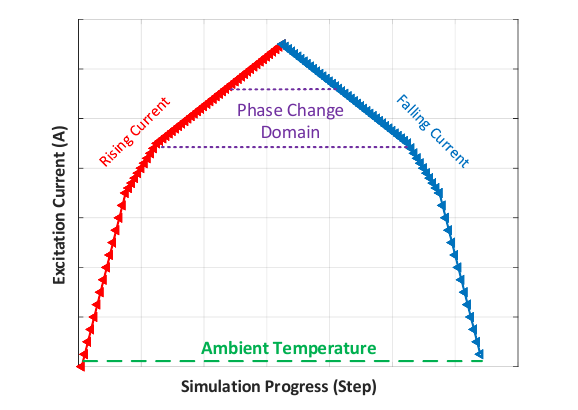
Figure 8. Excitation current per simulation step.